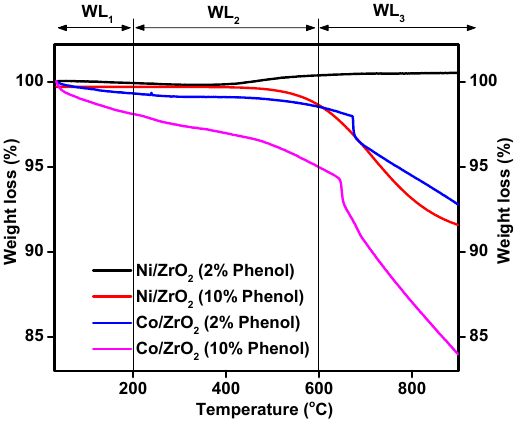
Figure 16. TGA profile of used Ni/ZrO 2 and Co/ZrO 2 catalysts.